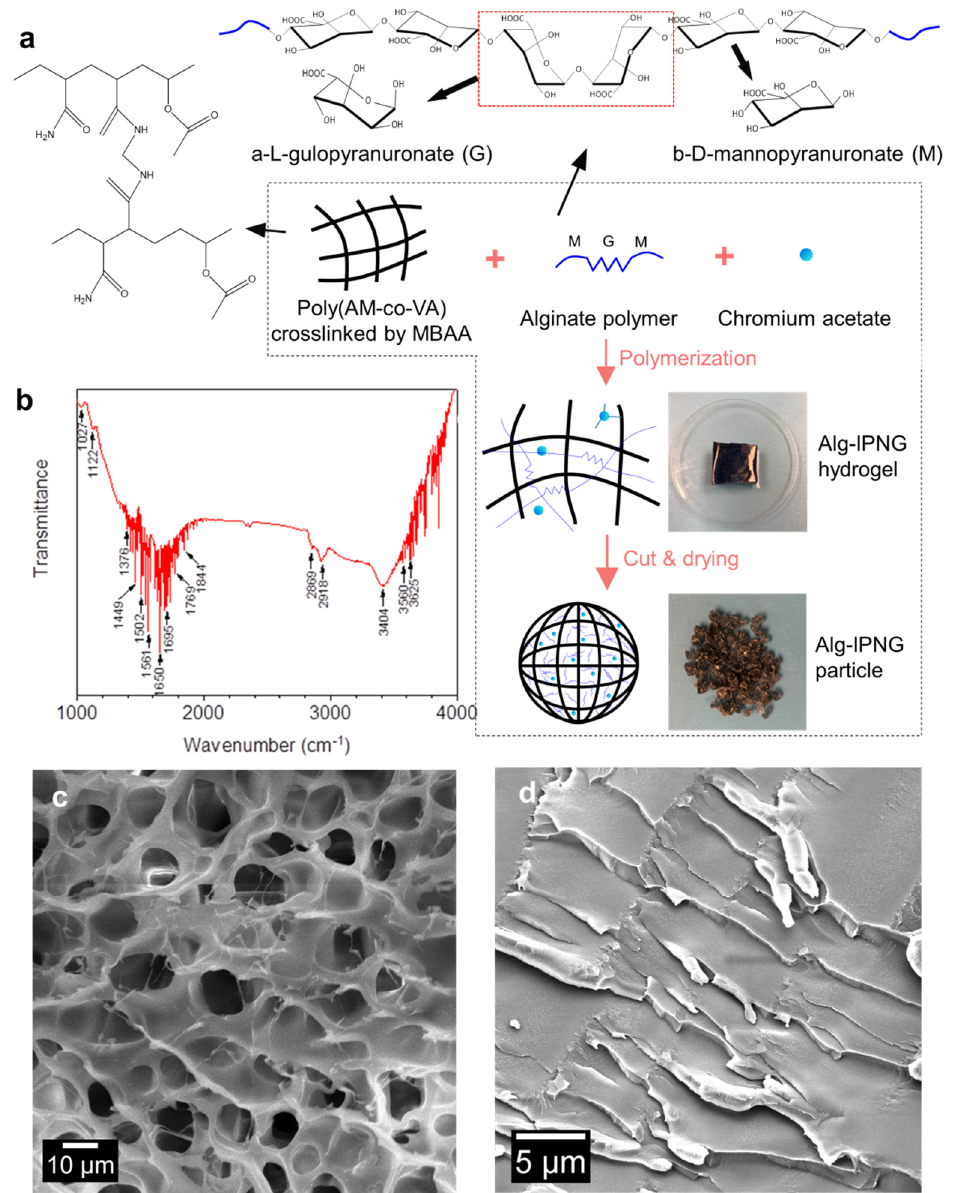
Figure 1. Schematic illustration of the preparation and the interpenetrating structure of the Alg − IPNG particle: ( a ) preparation; ( b ) FTIR detection result of the Alg − IPNG particles; ( c , d ) Microstructures of Alg-IPNG hydrogel and particle.